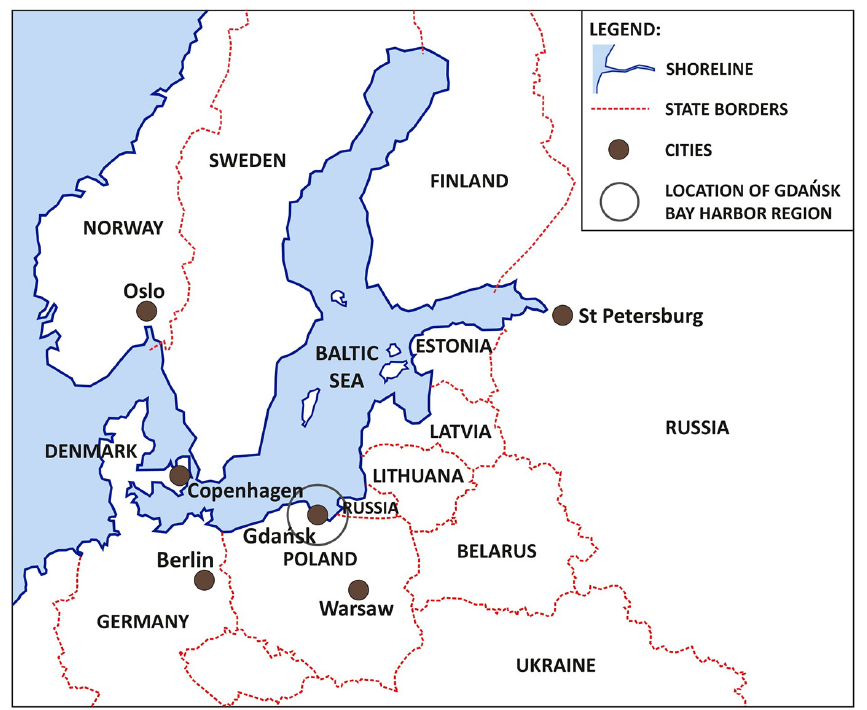
Figure 3. Location of the Gdańsk Bay port